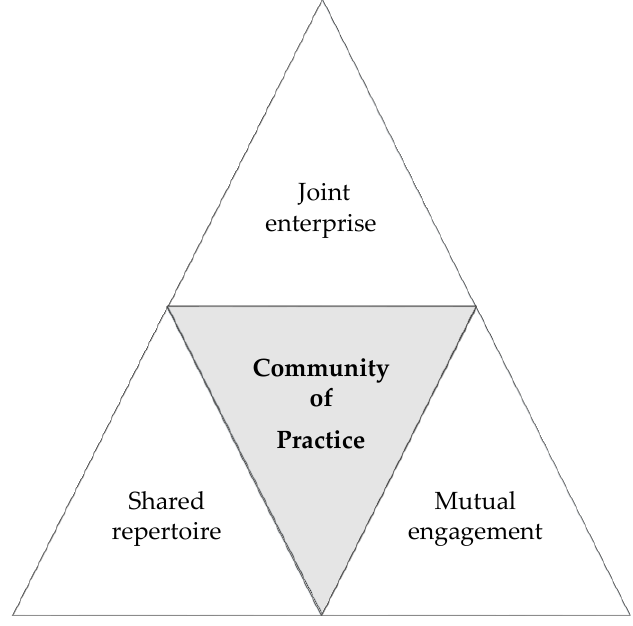
Figure 1. Three dimensions of a community of practice (CoP). Source: Based on Wenger (1998).